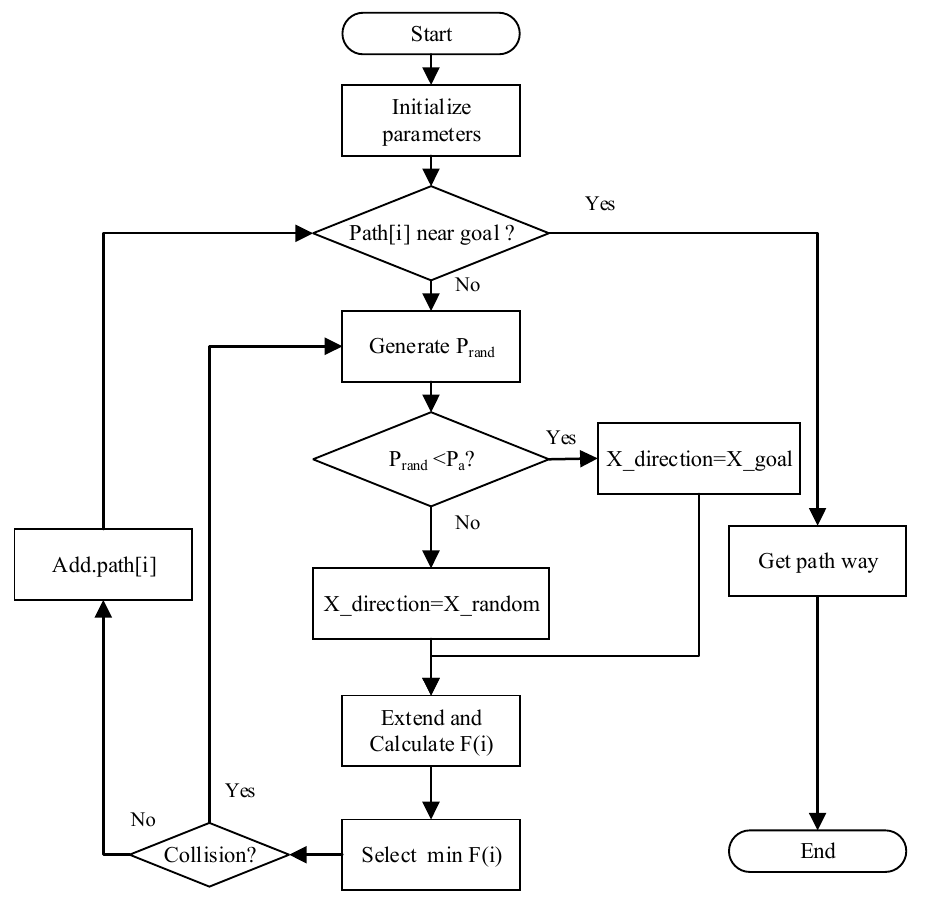
Figure 5. GA_RRT algorithm flow.